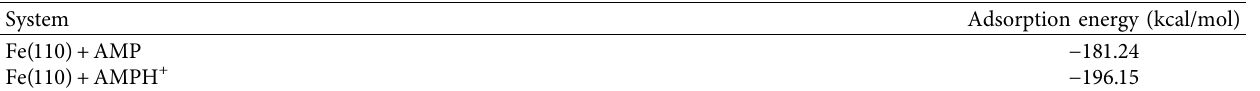
Table 4: The adsorption energies for AMP and AMPH + on Fe(110) surface obtained from the MC simulation.